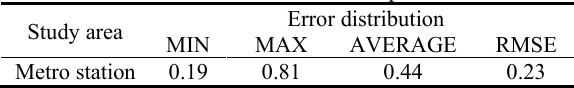
Table 2. The error distribution of the HLS point